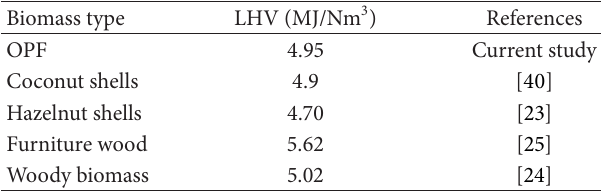
Table 3: Comparison of heating value of syngas from gasification of different